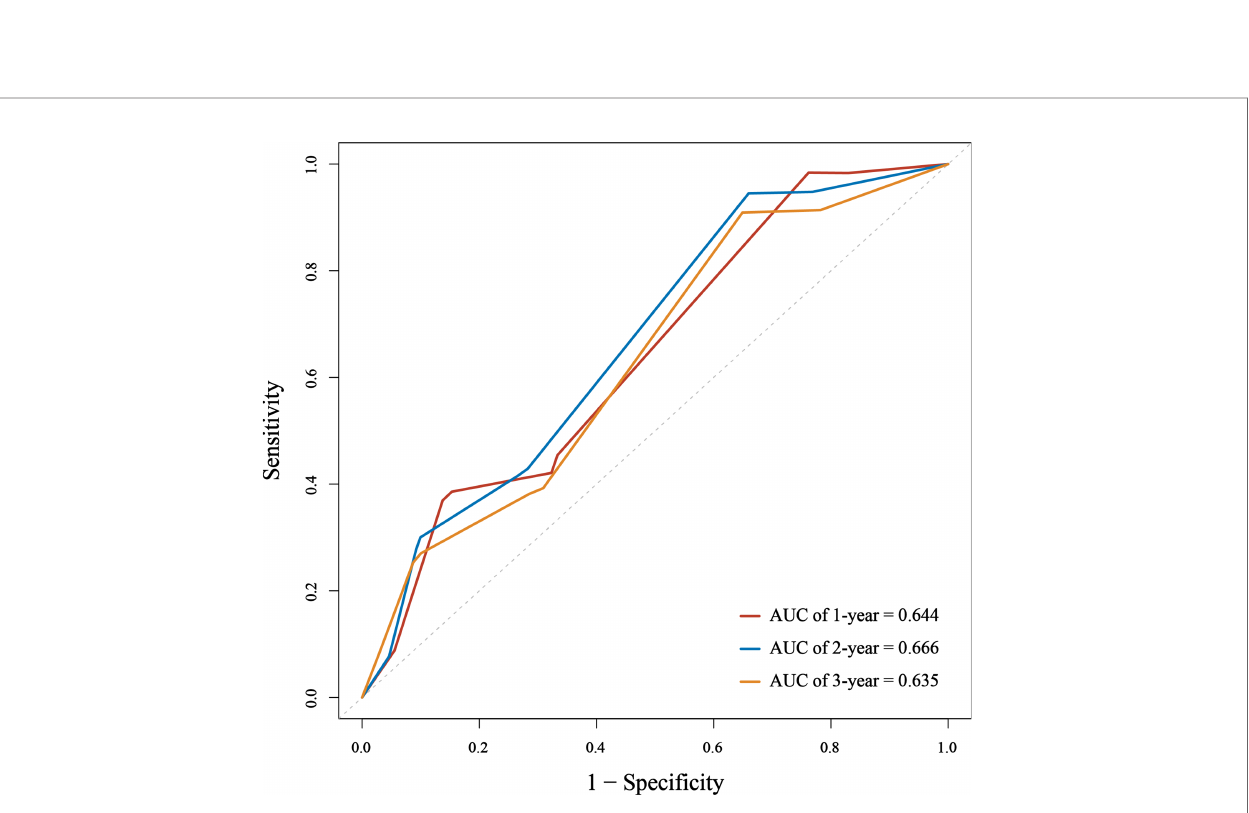
FIGURE 3 | The area under the receiver operating characteristic (ROC) curve (AUC) of the nomogram to predict 1-, 2-, and 3-year overall survival (OS) for small cell lung cancer (SCLC) patients.